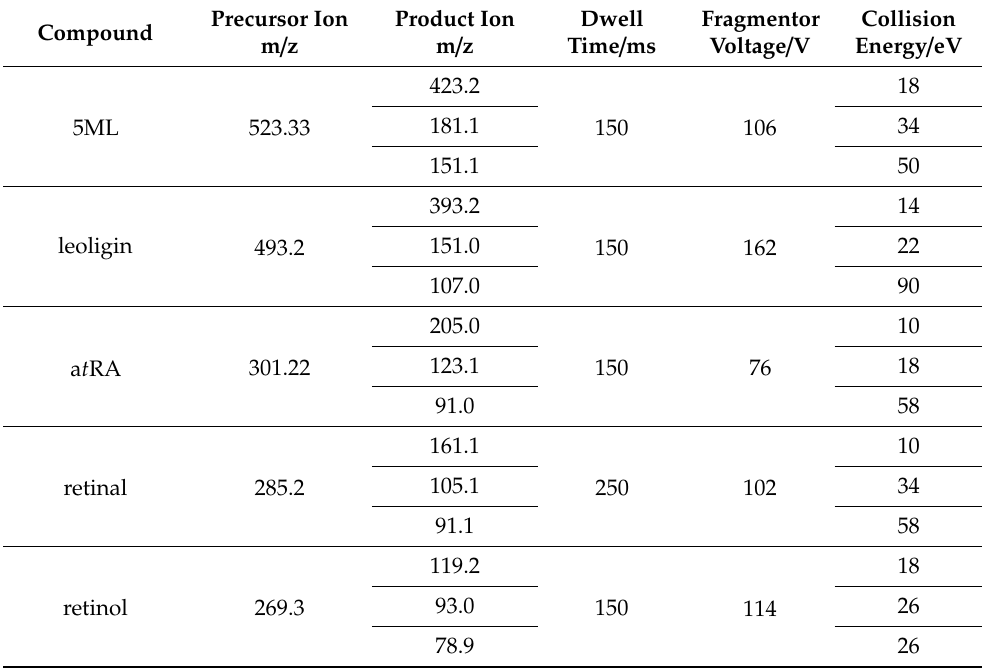
Table 1. Parameters and mass transitions for tandem mass spectrometry based quantitation of leoligins and